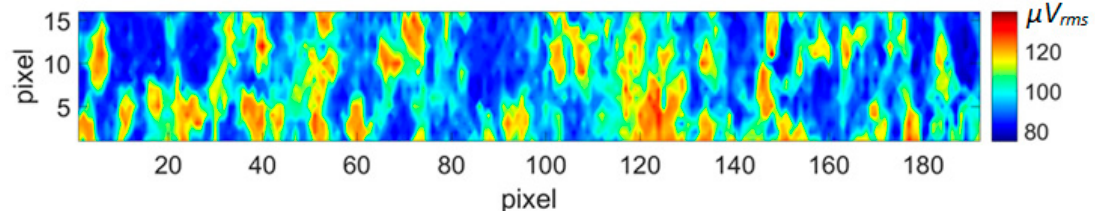
Figure 4. Noise power spatial map (over 2.5 s acquisition time, noise is integrated over 4 kHz bandwidth). [3] bandwidth)